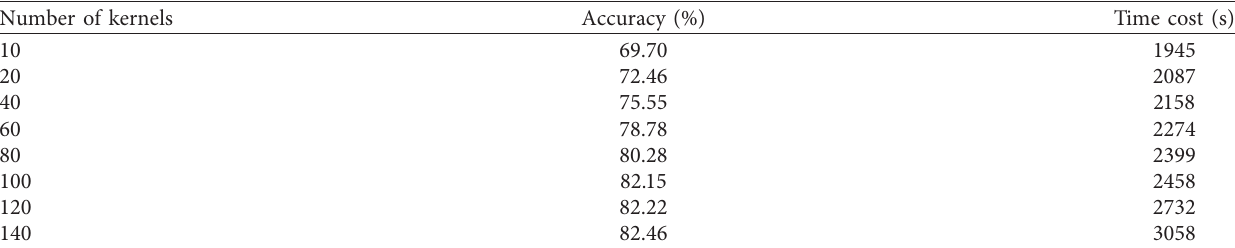
Table 3: Classification performance at different numbers of